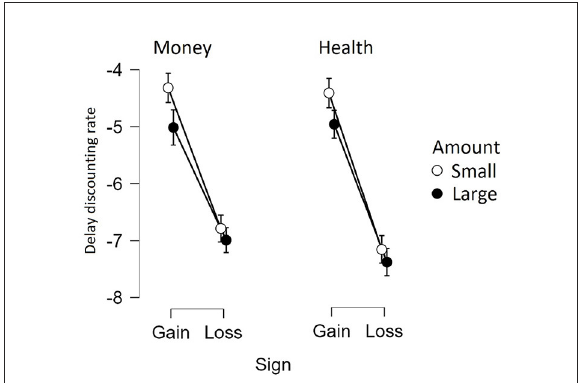
FIGURE1 The average discounting rate [ln( k )] in gain and loss conditions by outcome magnitude and domain (the whiskers represent 95% credible